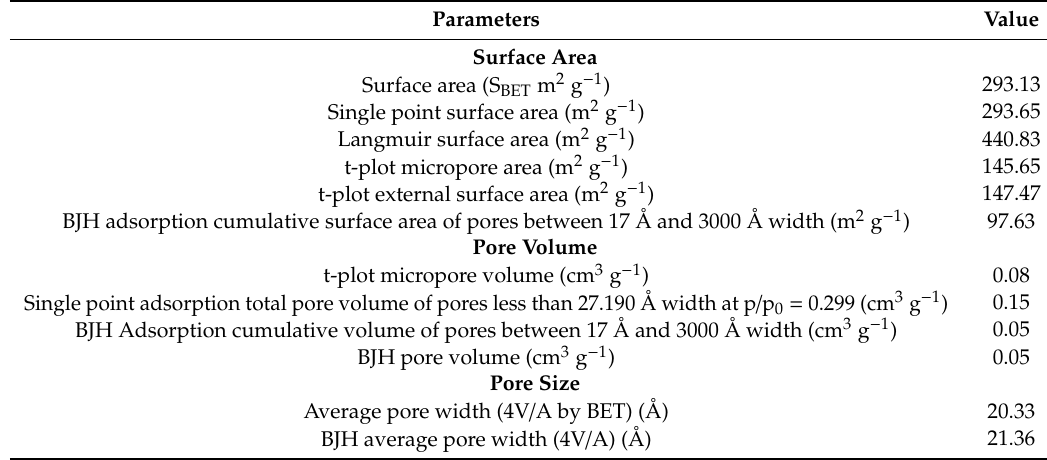
Table 1. Textural parameters of MA-AC400 adsorbent.